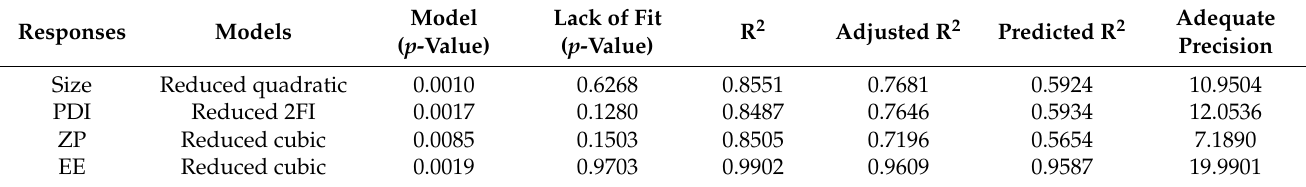
Table 3. Analysis of variance for the size, polydispersity index (PDI), zeta potential (ZP), and entrapment efficiency (EE).